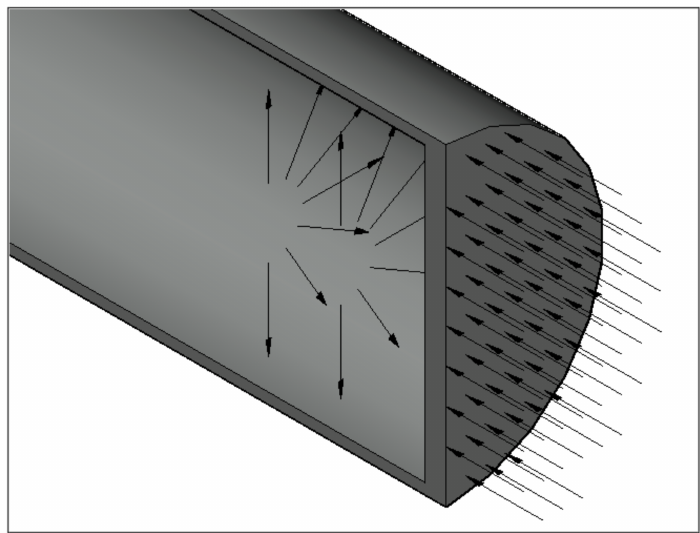
Figure 2. Loads applied on the pipe